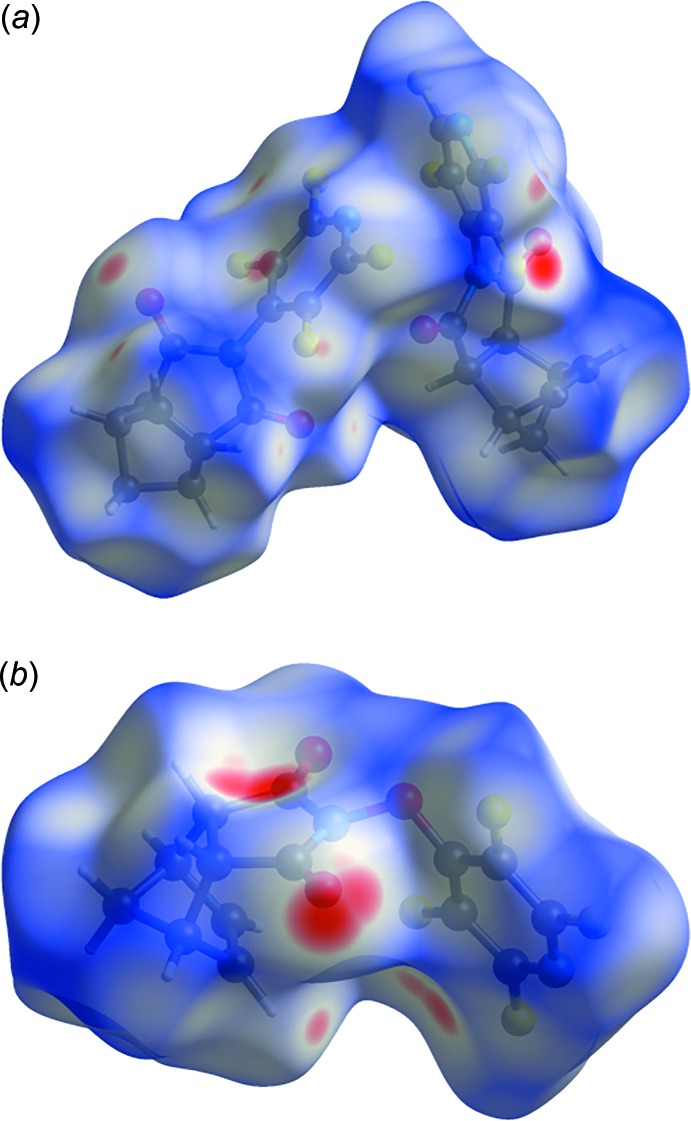
Hirshfeld surfaces of (a) I and (b) II mapped with d
norm.